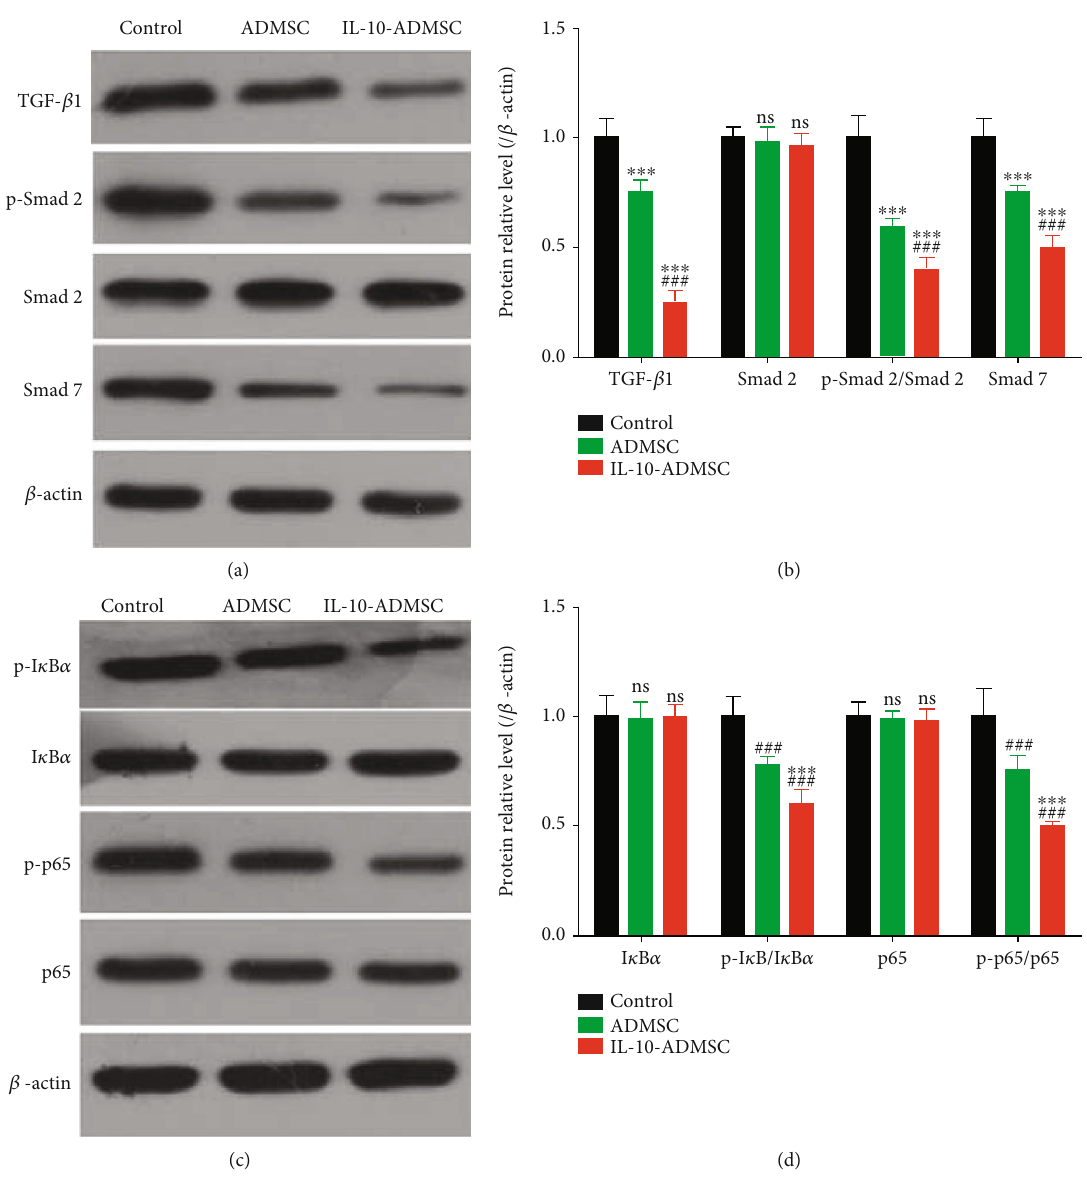
Figure 9: IL-10-modi fi ed ADMSC regulated TGF- β /Smads and NF- κ B pathway in wound. After 3 days of treatment in di ff erent ways, we detected the expression of key proteins in TGF- β /Smads and NF- κ B pathway in wound using immunoblotting. n = 6 ; data was expressed as ( SD ± mean ); P value was calculated by one-way ANOVA; ∗∗∗ was P < 0 : 001 vs. ADMSC group; ### was P < 0 : 001 vs. control